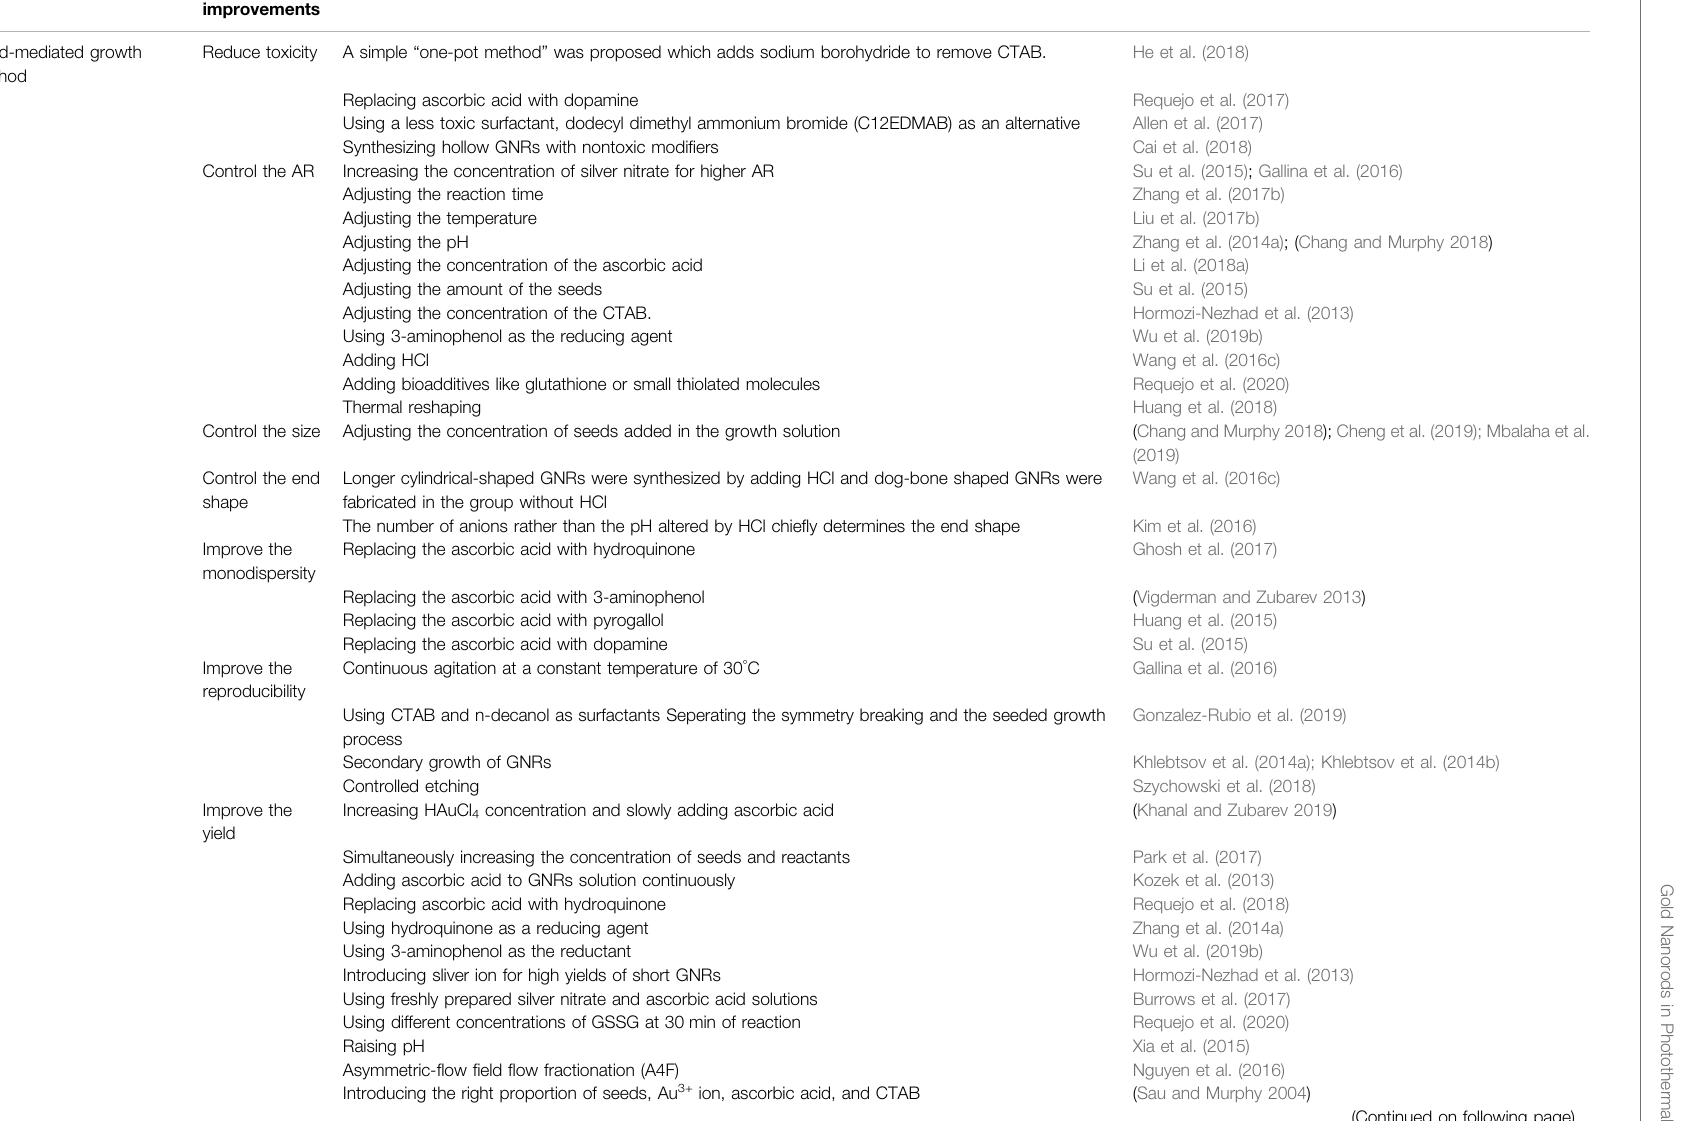
TABLE 1 | Summaries of synthesis methods of gold nanorods and their